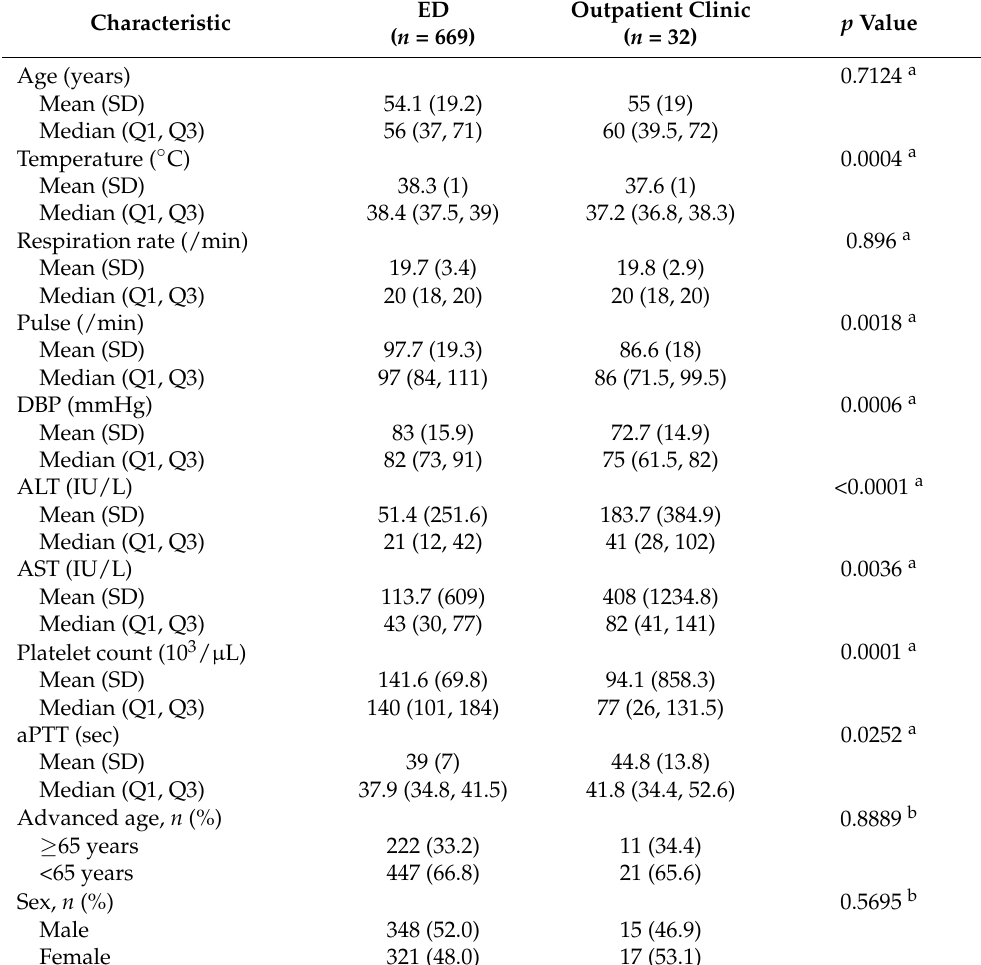
Table 1. Demographic characteristics of 701 enrolled dengue patients for model analysis. Characteristic